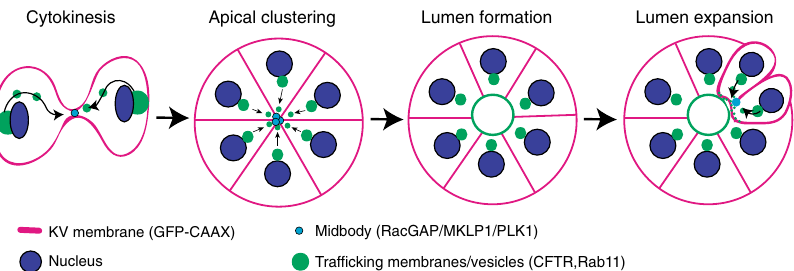
Fig. 7 Targeted membrane transport of CFTR towards the cytokinetic bridge is used to establish a lumen. Model depicting lumen formation through Rab11-mediated vesicle transport to the cytokinetic bridge. KV membrane (GFP-CAAX — magenta), midbodies (RacGAP/MKLP1/PLK1 — cyan), vesicles (CFTR/Rab11 — green), and nuclei (blue)